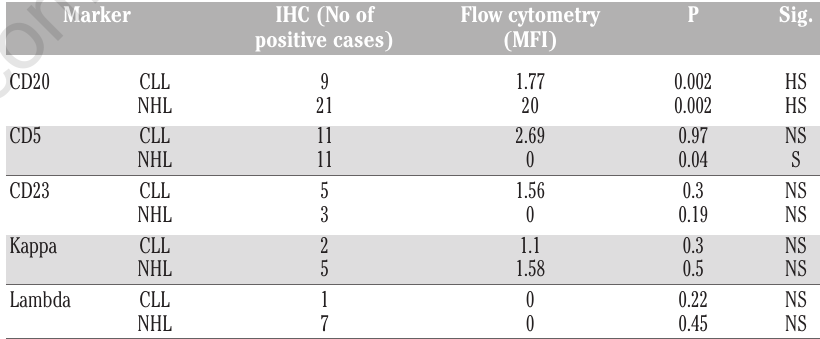
Table 3. Comparing percent positivity of immunohistochemistry and flow cytometry mean fluorescence intensity in chronic lymphocytic leukemia and non Hodgkin lym- phoma groups.